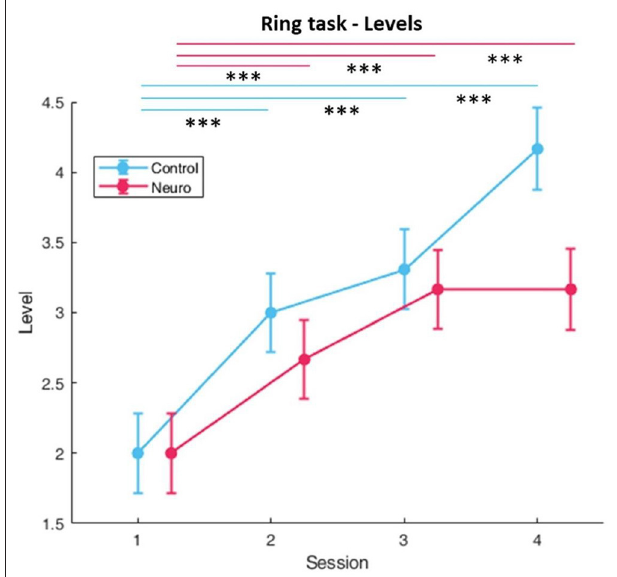
FIGURE 12 | Training levels reached for ring task over each session per experimental group. Both conditions displayed significant level increases over time (whiskers are SEM, *** p <